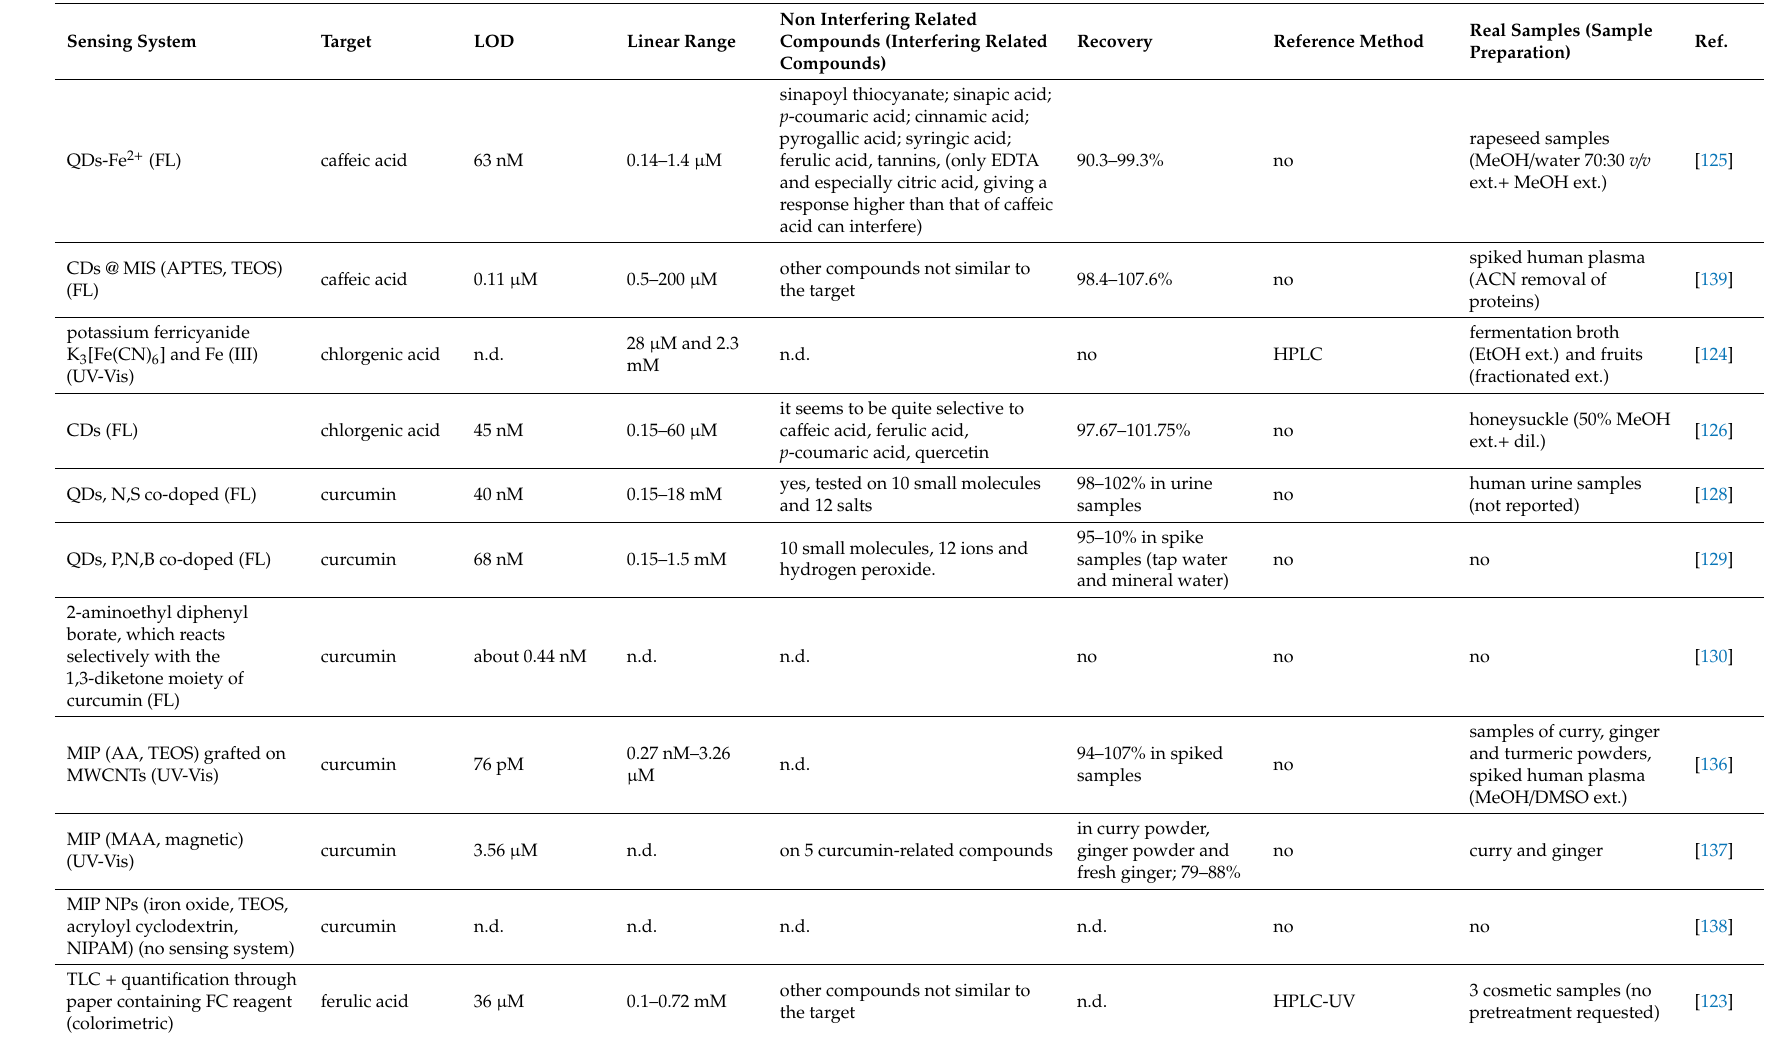
Table 3. Performance of optical / fluorimetric